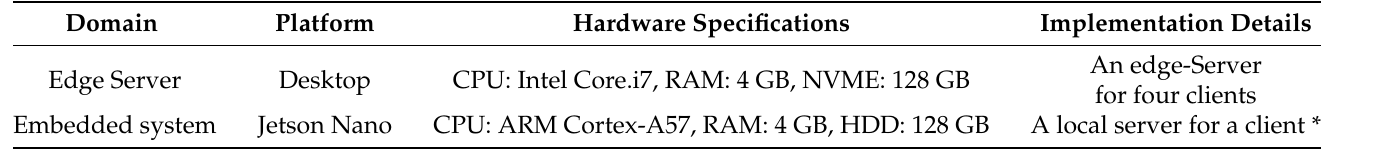
Figure 4. ( a ) Algo3, Depthconv-RNN, Reprinted from ref. [11]; ( b ) Algo2, FCN-LSTM [8], Reprinted from ref. [34] (initially proposed for time-series classification) and ( c ) Algo1, DeepConvRNN-Attention [6]. Table 3. Specifications of embedded devices and edge